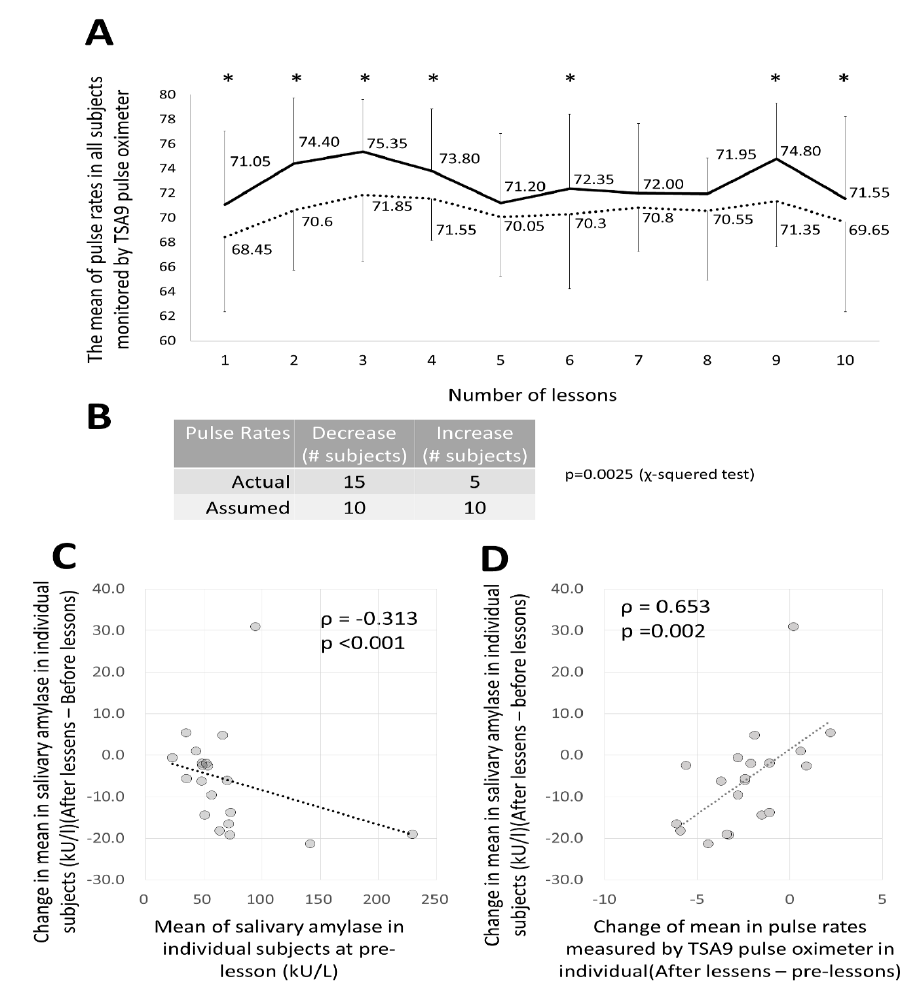
Figure 7. Pulse changes in subjects before and after lessons and changes in salivary amylase levels that serve as stress indicators. ( A ) Changes in pulse rate as measured by TAS9VIEW ® . The horizontal axis shows the first to the tenth lesson. The solid line shows the average pulse rate of the 20 subjects before each lesson. The dotted line represents the average value after the lesson. The pulse rate decreased significantly, except at the fifth, seventh, and eighth lessons. ( B ) The average pulse rate for all of the 10 lessons of the 20 subjects: the pulse rate declined in 15 subjects and rose in 5 subjects. The chi-squared test was performed with each half as a predicted value. There were many subjects whose value decreased significantly. ( C ) For salivary amylase, the horizontal axis shows the average value before each lesson of the 20 subjects, and the vertical axis shows the change in the average values (post-value minus pre-value) before and after the lessons of these subjects. This shows a significant inverse correlation. ( D ) Horizontal axis: change in pulse rate value of the 20 subjects as measured by TAS9VIEW ® (post-value minus pre-value); vertical axis: change in salivary amylase value before and after lessons of the subjects (post-value minus pre-value). This shows a significant positive